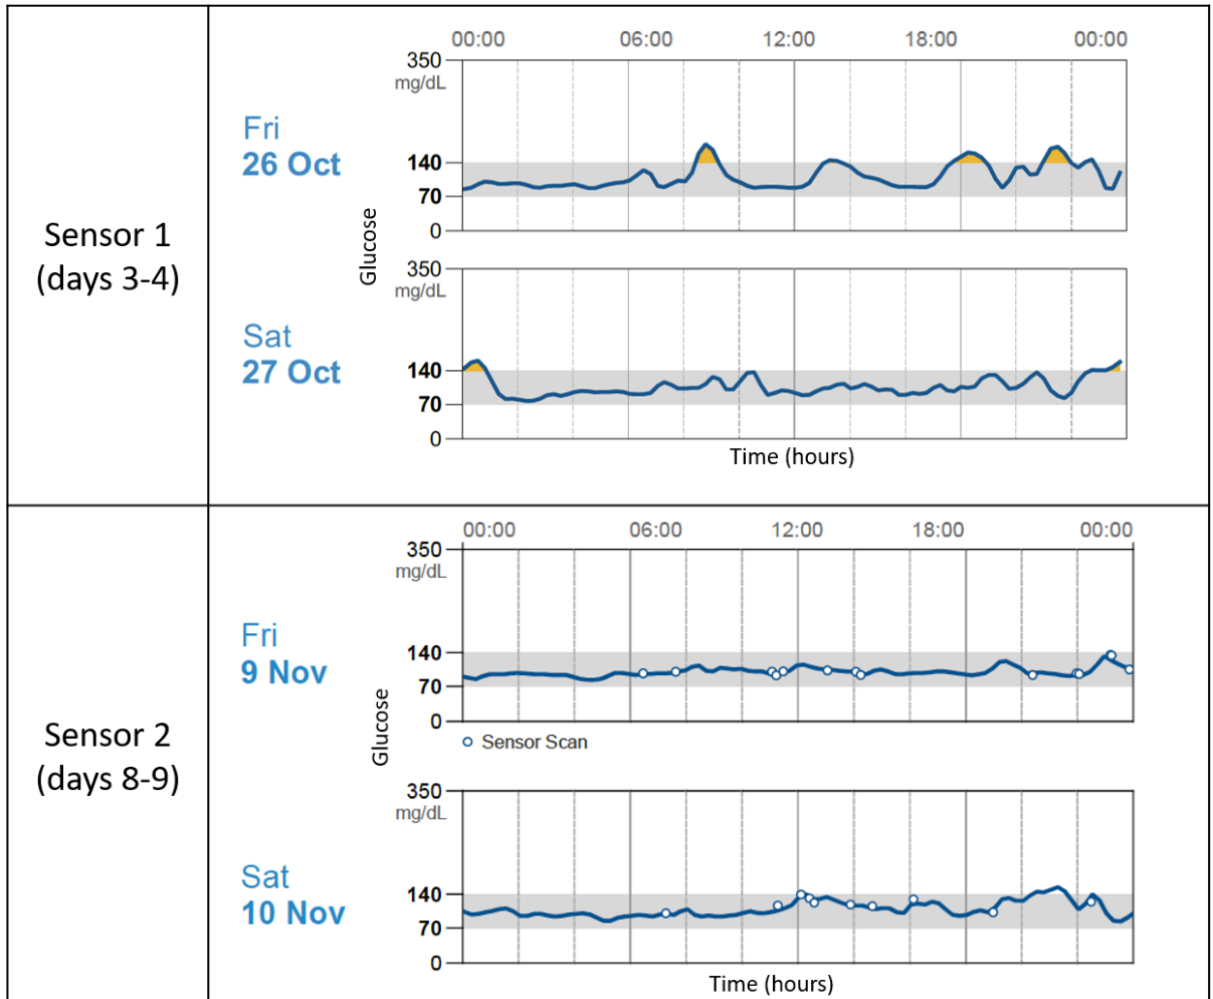
Figure 3. Example of participant glucose trends from both sensor periods captured by Abbott continuous glucose monitor